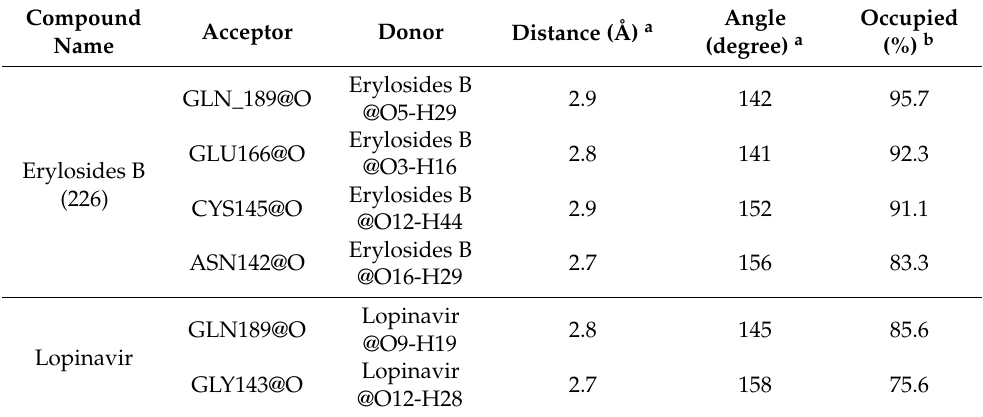
Table 3. Distance, occupancy, and hydrogen bonding for erylosides B (226) and lopinavir with key M pro amino acid residues.